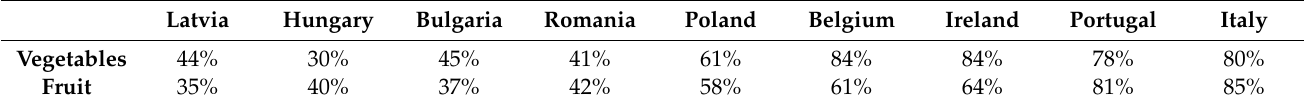
Table 6. Daily consumption of fruit and vegetables in some of the European Union * countries, 2017